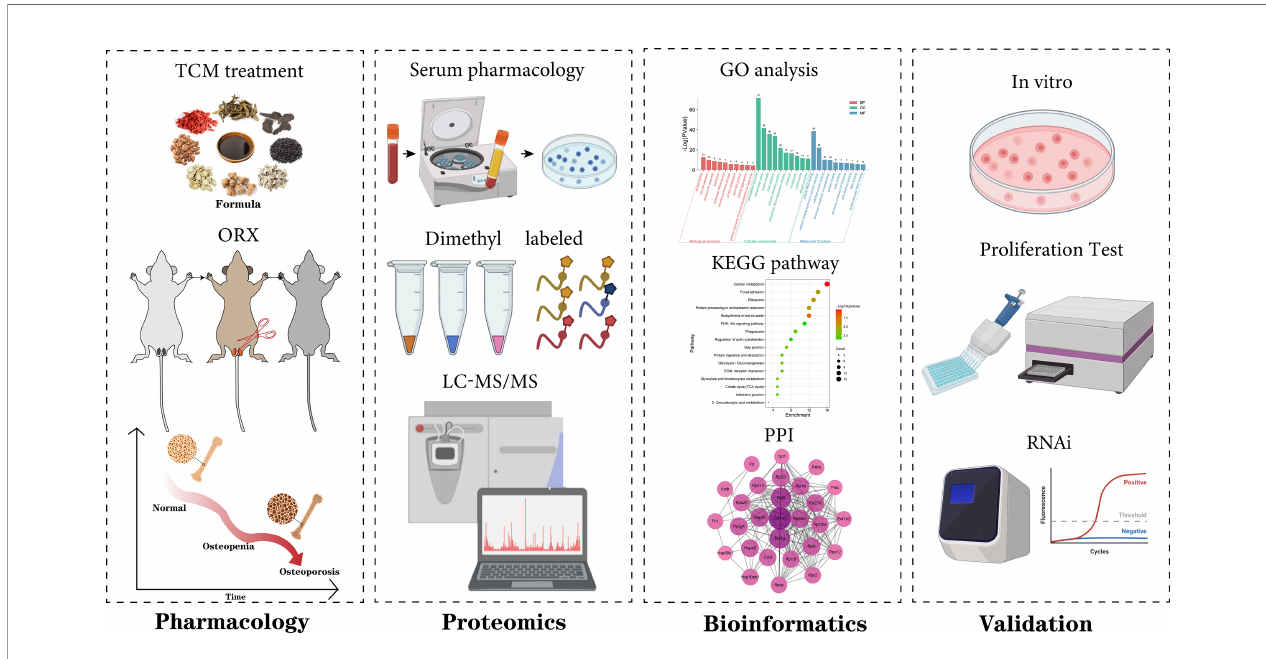
FIGURE 1 | The strategies of revealing the anti-osteoporosis mechanism of